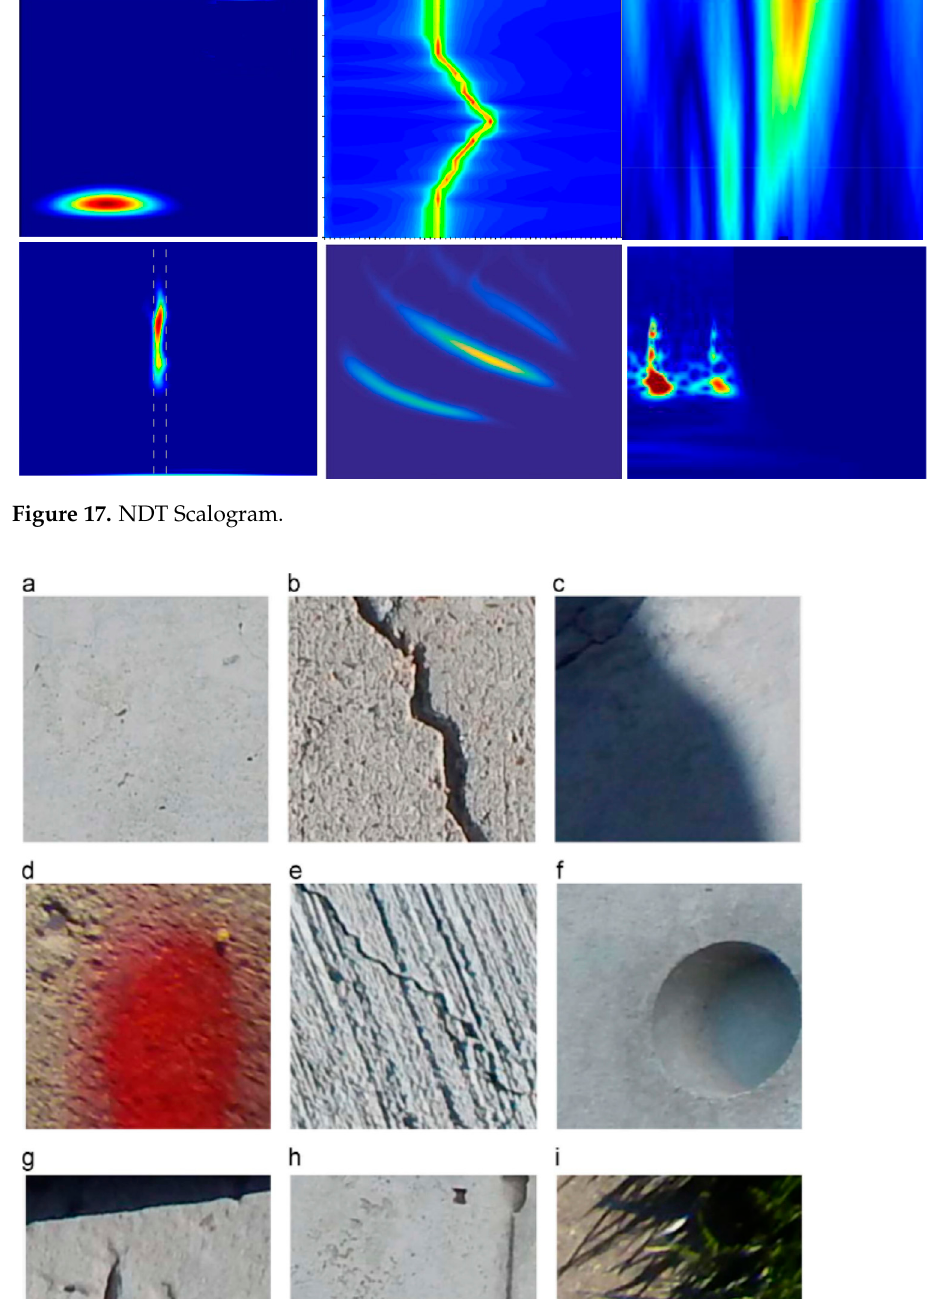
Figure 18. SDNET2018 ( a ) fine cracks, ( b ) coarse cracks, ( c ) shadows, ( d ) stains, ( e ) rough surface finishes, ( f ) inclusion sand voids, ( g ) edges, ( h ) joint sand surface scaling, and ( i ) obstructions.